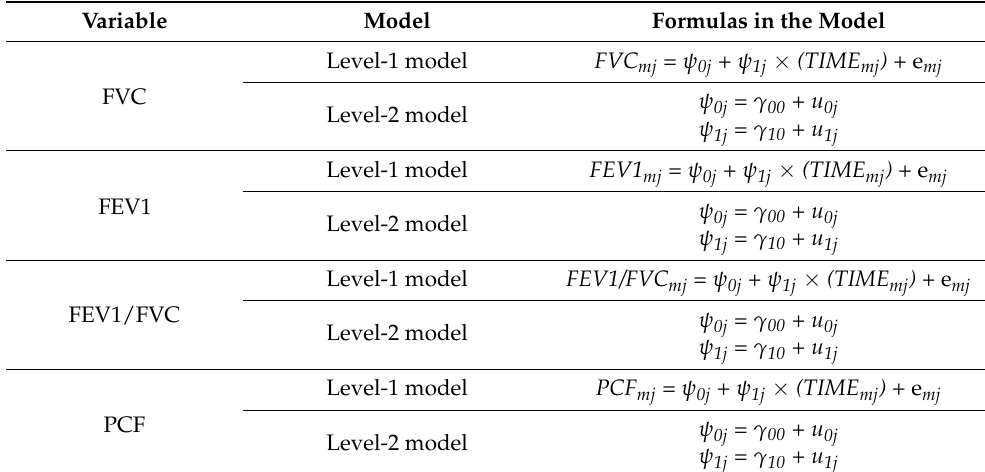
Table 2. Composition of the null